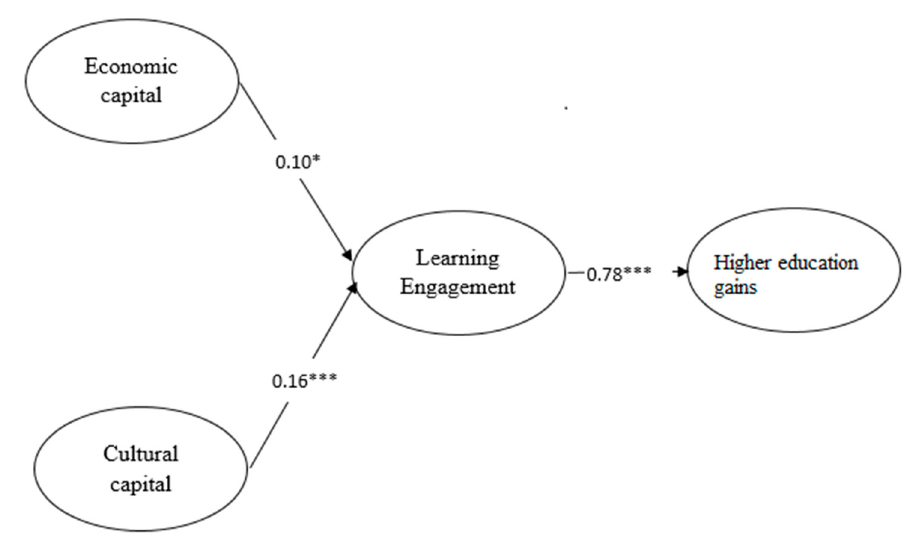
Figure 2. Mediating effect of learning engagement. * p < 0.05, *** p < 0.001 .